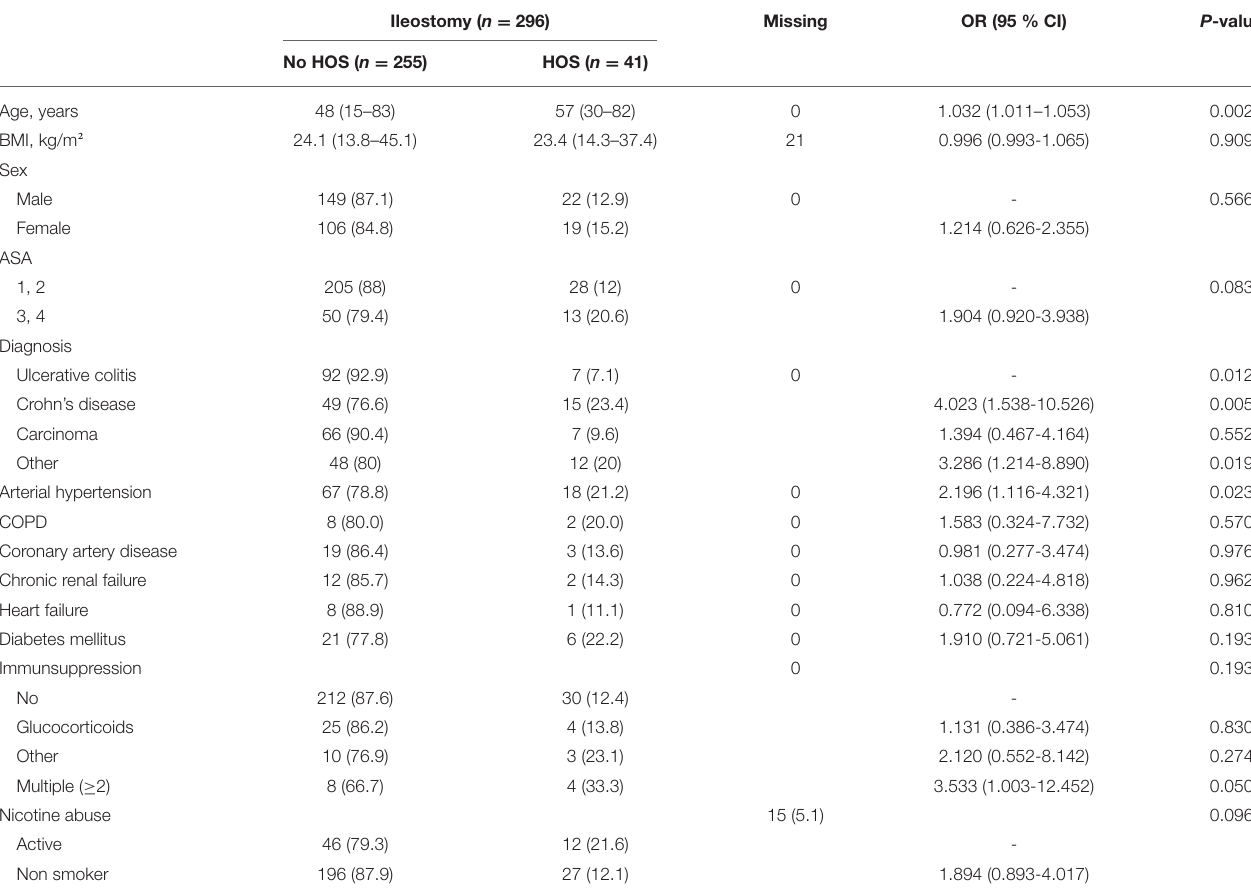
TABLE 2 | Patient-specific risk factors, univariate analysis. Ileostomy ( n = 296) Missing OR (95 % CI) P